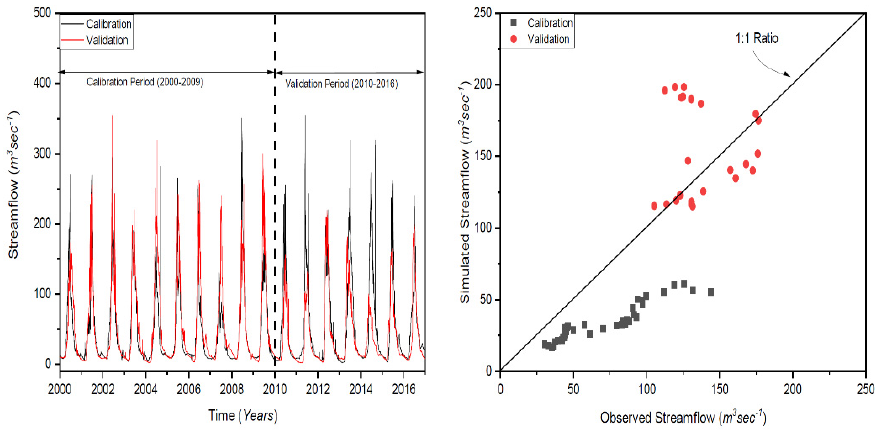
Figure 5. Validation and calibration of the HBV by year for Naran.